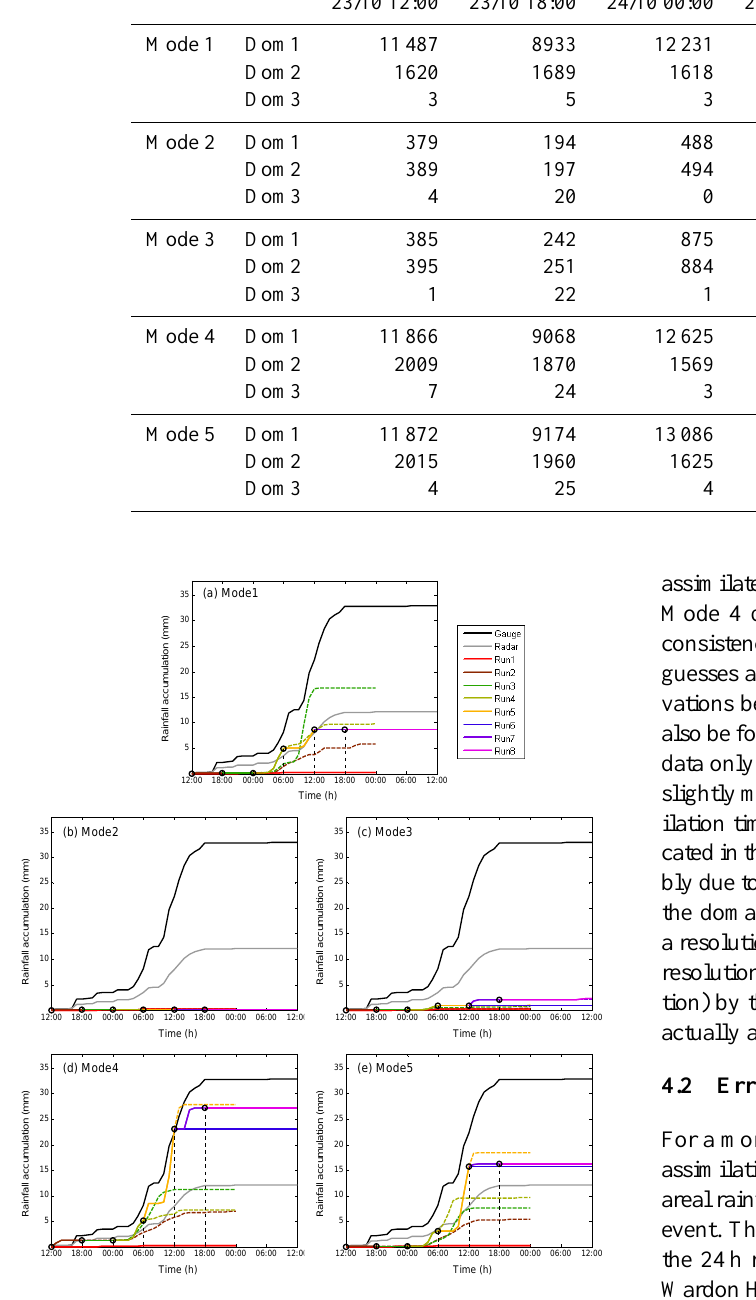
Figure 6 Cumulative curves of the forecast rainfall after applying the five modes of data assimilation from 23 October 1999 at 12:00 to 25 October 1999 at